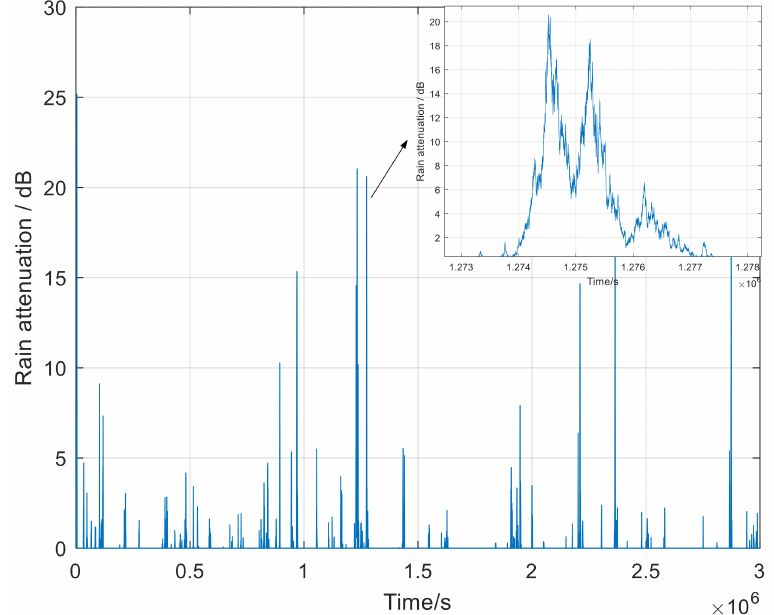
Figure 4. Rain attenuation time